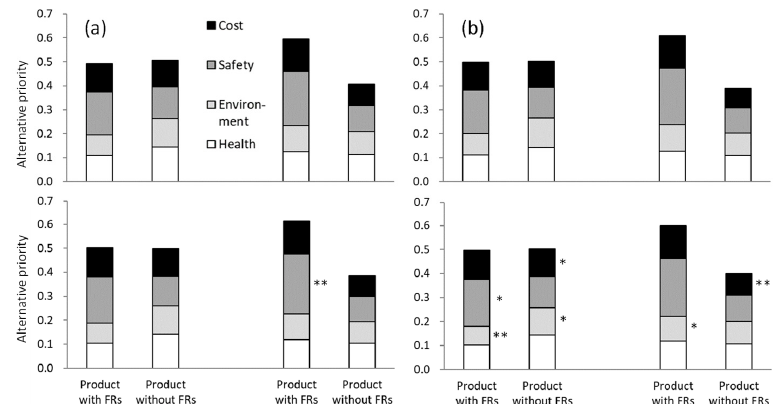
Figure 8. Comparison of priorities of product alternatives for subjects grouped according to risk acceptance and risk-avoidance orientation: ( a ) fear of rare accidents; ( b ) fear of frequent accidents or worry about health (left: before watching video; right: after watching video; upper: upper group of factors; lower: lower group of factors). Two-sided test, alternative hypothesis: “upper group of factors” ≠ “lower group of factors”, * p < 0.05; ** p < 0.01.